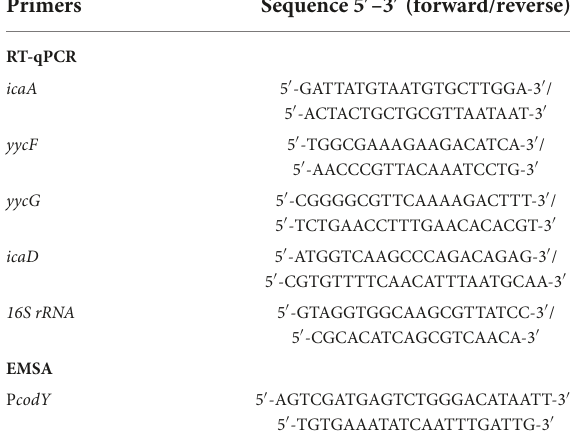
TABLE 1 Sequences of primers in this